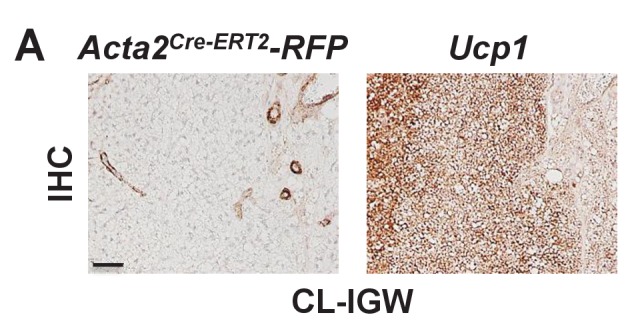
Acta2+ smooth muscle cells are not a source of Adrb3 induced beiging.(A) Representative RFP and Ucp1 IHC staining of IGW depot sections from Acta2Cre-ERT2; RosaR26RFP treated with CL for seven days (n= 6/group). Scale bar = 100 µm.